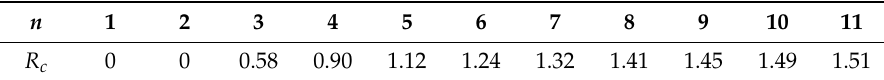
Table 2. The random consistency ratio I R